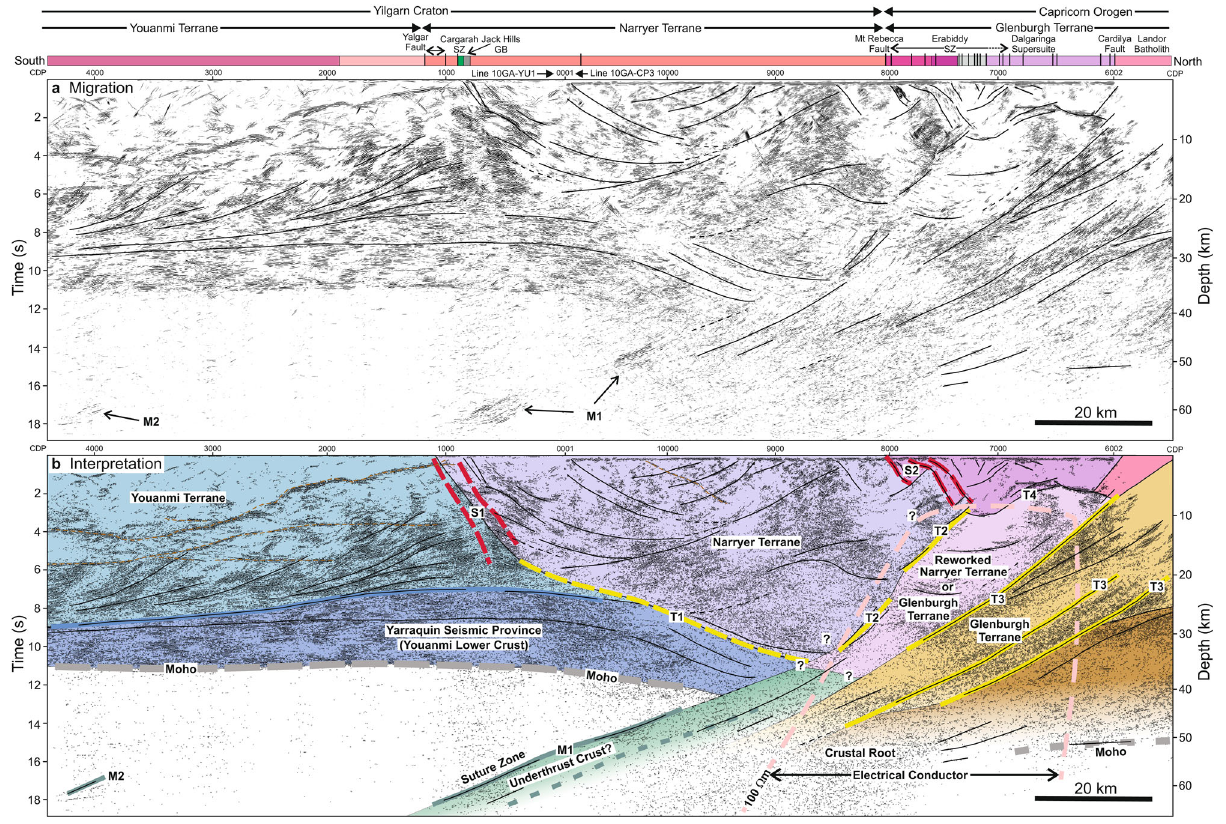
Fig. 2 Seismic re fl ection section showing lines YU1 and CP3. a Segment migration 64 of combined seismic section constructed from seismic lines YU1 and CP3. Prominent re fl ections, and the boundaries between major re fl ective units are interpreted. Overview of geological units: grey — Proterozoic and Archaean metasedimentary rocks, green — volcanic greenstone rocks, pink/red — granites and granitic gneiss. b Kirchhoff migration superimposed on interpretation of major crustal blocks and the shear zones related to their evolution. Dashed pink line — 100 Ω .m iso-resisitivity contour around a steeply dipping to subvertical conductor associated with the boundary between the Glenburgh and Narryer Terranes. Dashed brown lines — interpreted sills, dashed thick green line — possible more northerly position of M1 along line